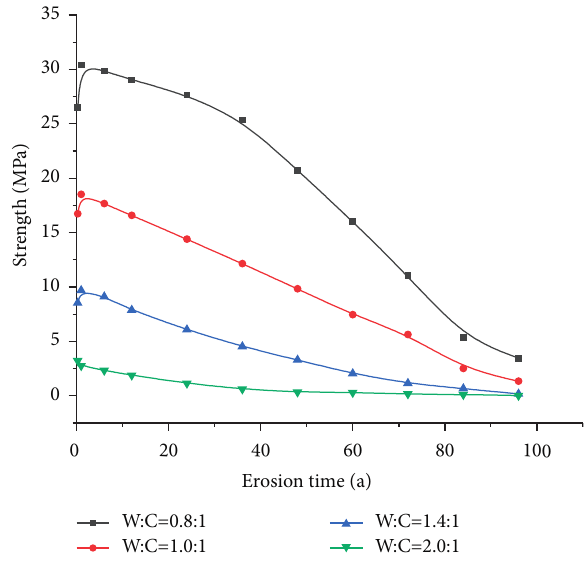
Figure 4: The weakening law of grouted body strength with